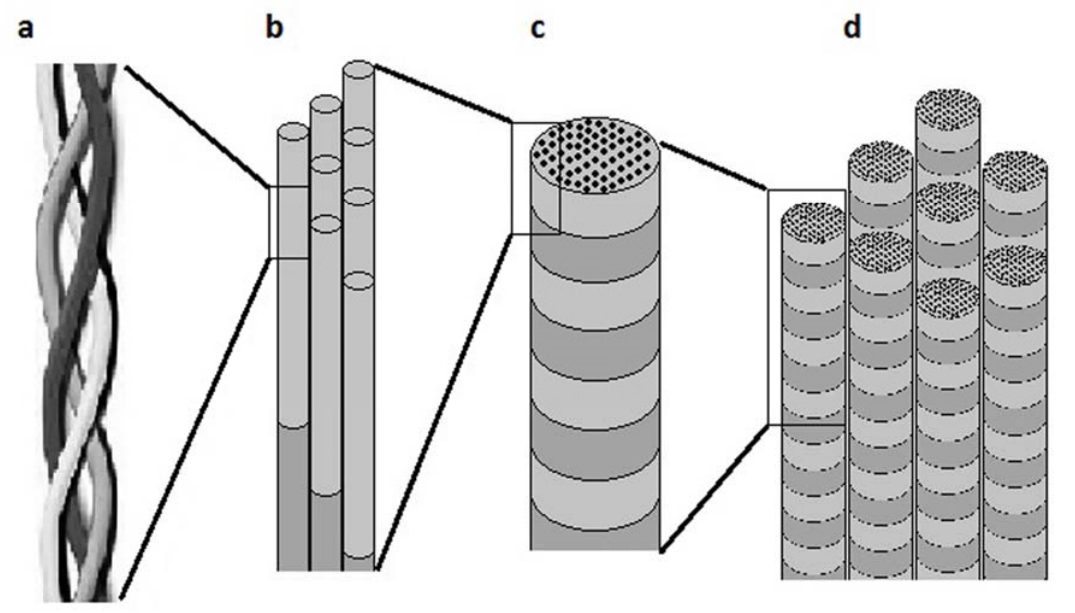
Figure 1. (a) Schematization of a collagen α chain triple helix segment. (b) Assembled tropocollagen molecules. (c) Collagen fibril ranging from 10 to 300 nm in diameter. (d) Aggregated collagen fibrils forming a collagen fiber with a diameter ranging from 0.5 to 3 μ